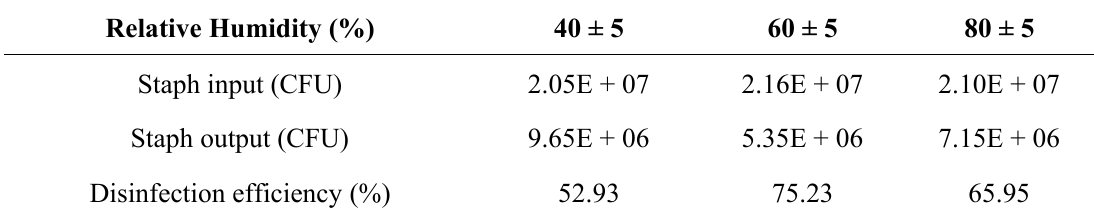
Table 2. Effects of relative humidity on photocatalytic disinfection efficiency of